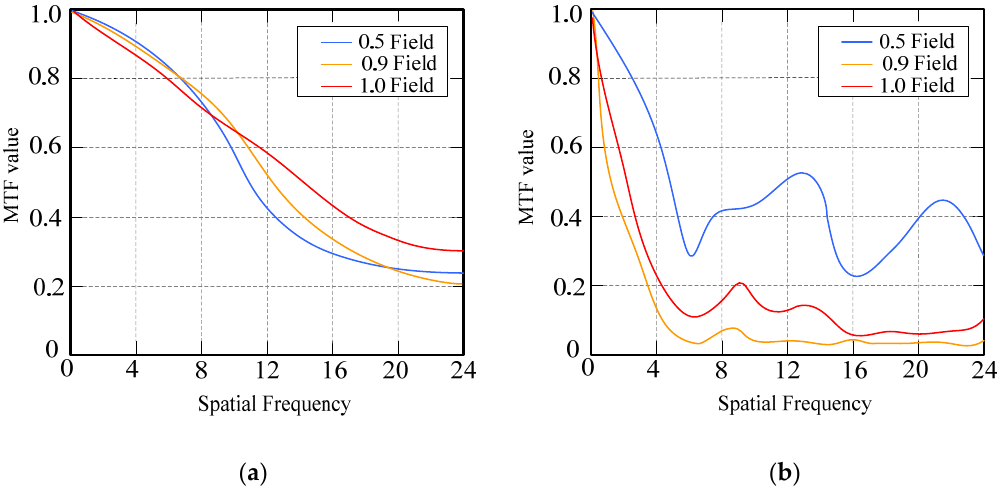
Figure 9. MTF graph comparison. ( a ) MTF curve designed in this paper, ( b ) MTF curve of the sam- ple.